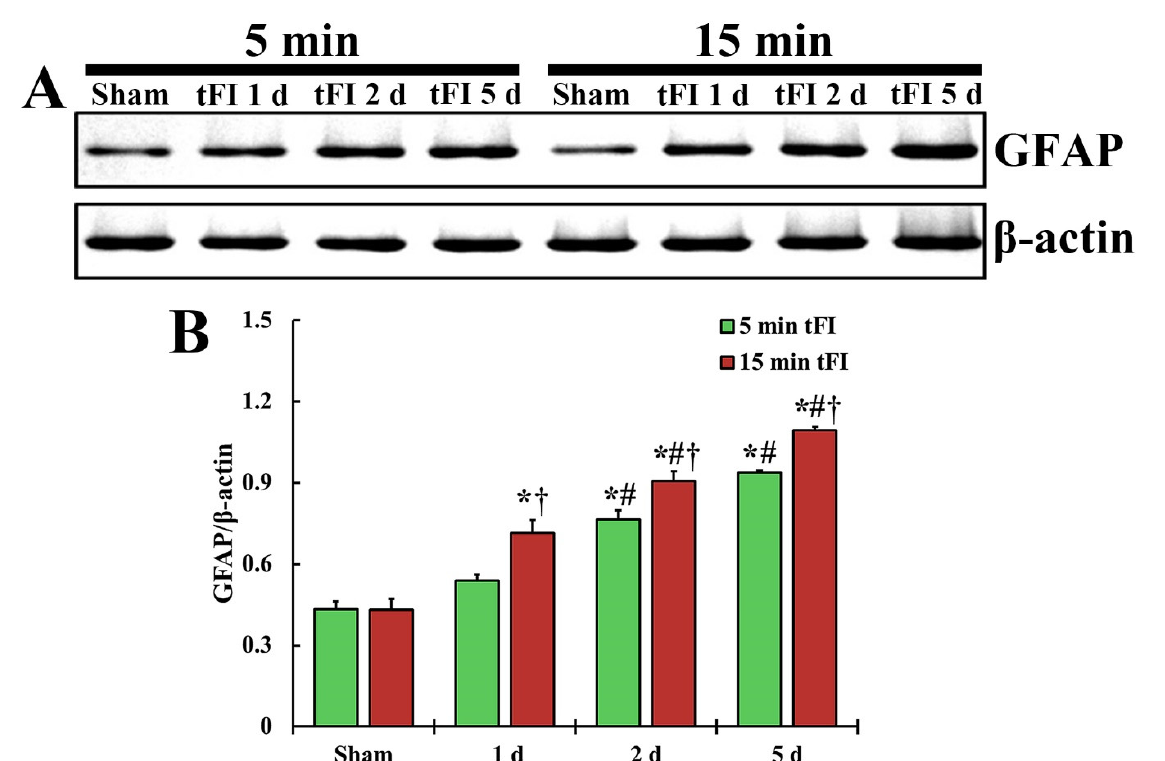
Figure 5. ( A ) Representative blot image and quantitative analysis of GFAP protein level in the motor cortex of the mild sham, mild tFI, severe sham and severe tFI groups on days 1, 2 and 5 after tFI. ( B ) Densitometric analysis of GFAP protein level by normalization to the level of β -actin. The bars indicate the means ± SEM ( n = 5, respectively; * p < 0.05, significantly different from mild or severe sham group, # p < 0.05, signi fi cantly di ff erent from corresponding former time group, and † p < 0.05, significantly different from mild tFI group at the corresponding time). The bars indicate the means ± SEM.